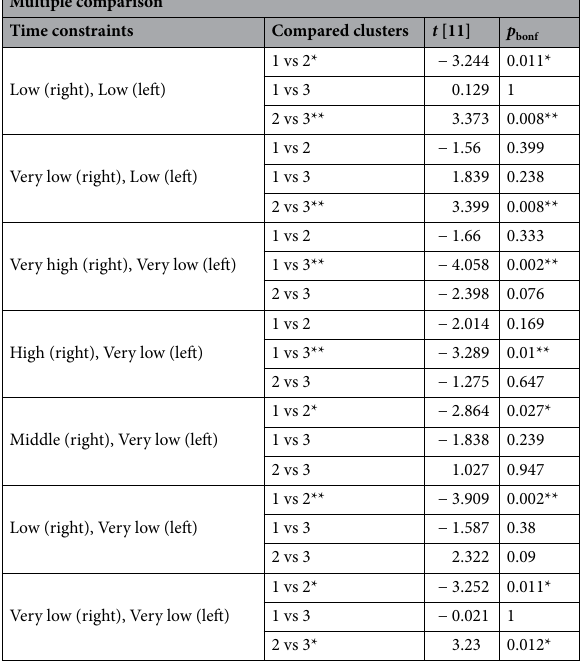
Table 2. Multiple comparisons (3 [cluster]) on the occurrence probability. *< 0.05, **<